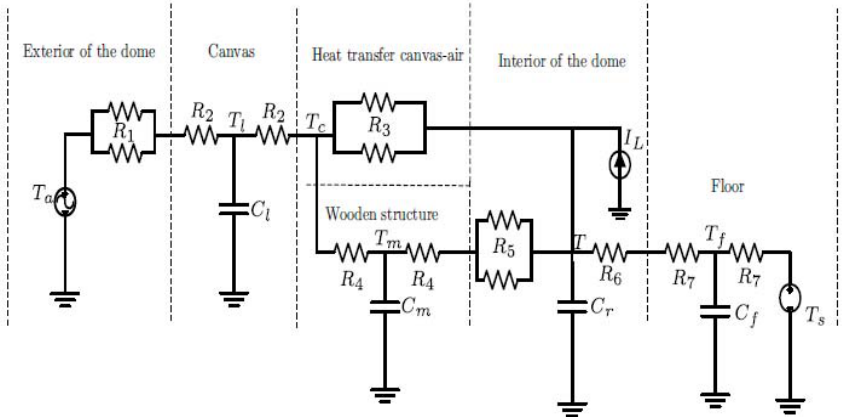
Figure 3. Circuit representation. Surface area ( 𝐴 ), thickness ( 𝐿 ), thermal conductivity ( 𝑘𝑡 ), density ( 𝜌 ), specific heat ( 𝐶𝑒 ).